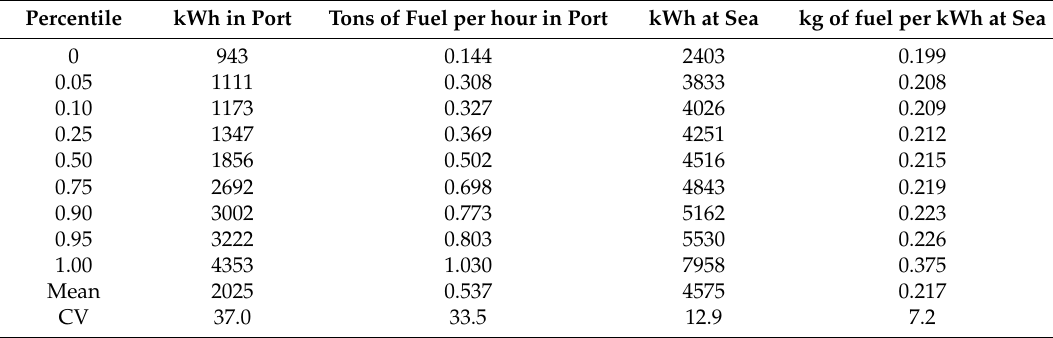
Table 5. Energy consumption and specific fuel consumption for